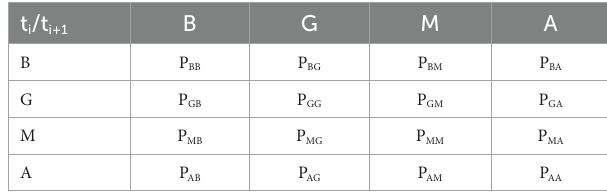
TABLE 3 Markov transition probability matrix ( k =